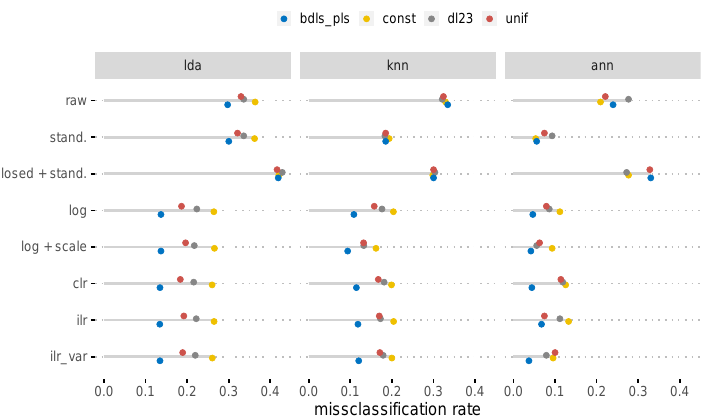
Figure 5. Misclassification rates of various classification methods based on different pre-processing and replacement strategies applied to the honey samples. Abbreviations (for details, see Section 3): lda: linear discriminant analyis, KNN: k-nearest neighbor, ANN: artificial neural network; bdls: below detection limit using (censored) partial least squares regression, const: constant, dl23: two- thirds of the detection limit, unif: uniform; closed + stand: closed and standardized data, raw: raw, i.e., non-transformed, log: log transformed, scale: scaled, ilr: isometric log-ratio transformed (i.e., pivot coordinates), clr: centered log-ratio